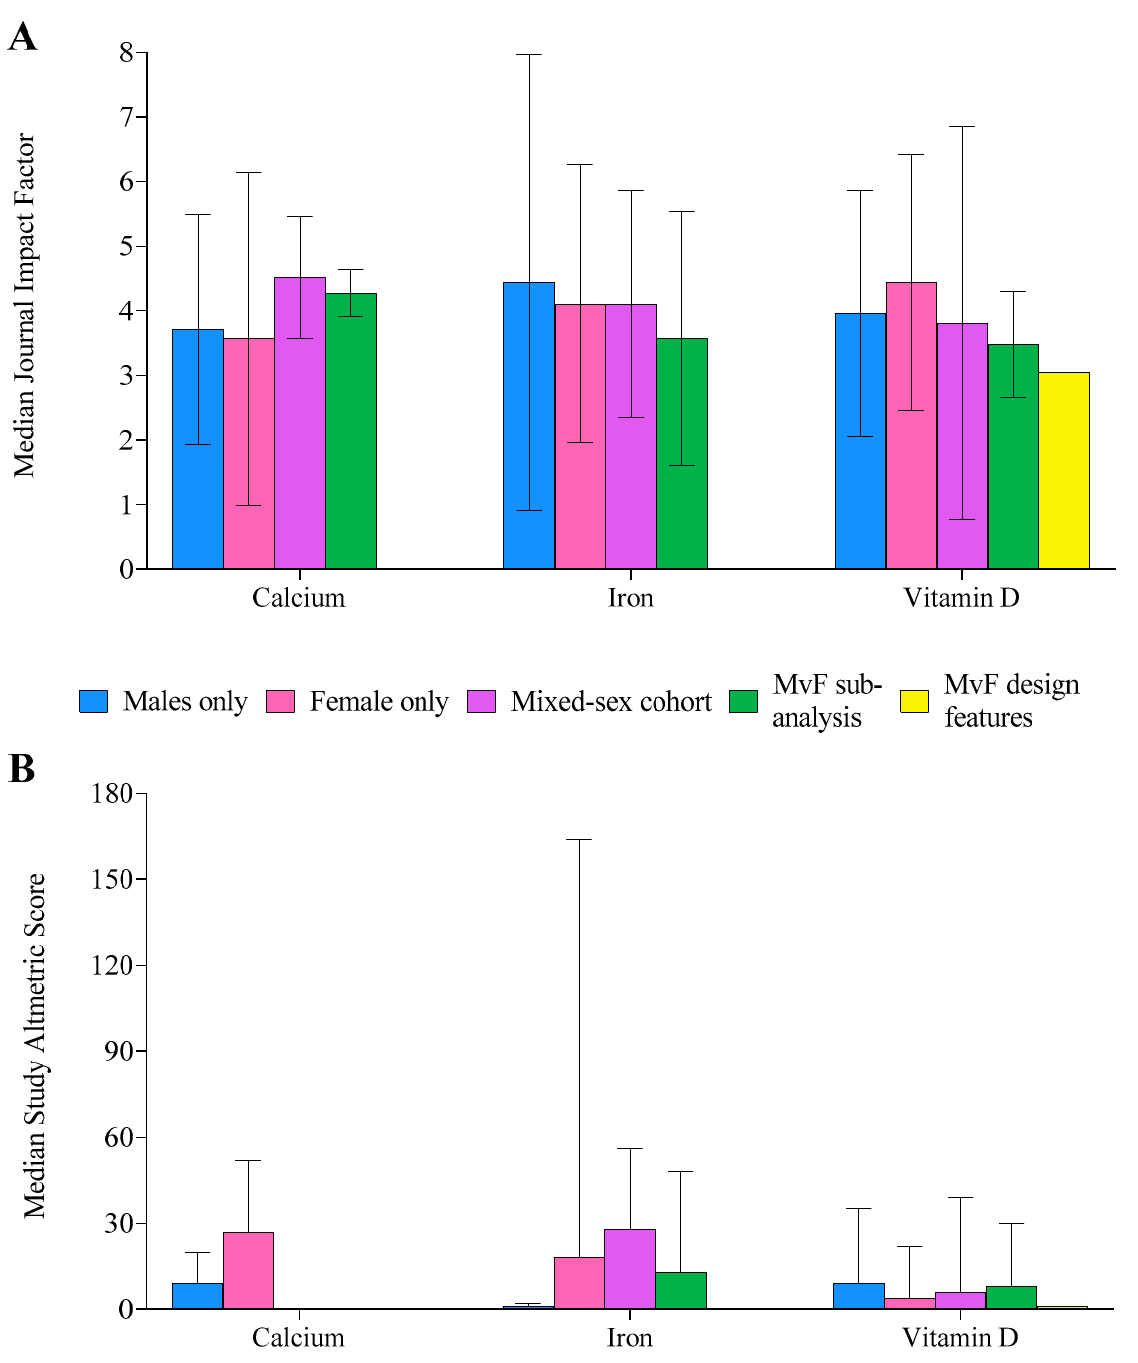
Figure 7. Median journal impact factor ( A ) and Altmetric score ( B ) for each supplement, separated by population studied. Male (M), female (F). Error bars display the interquartile range.